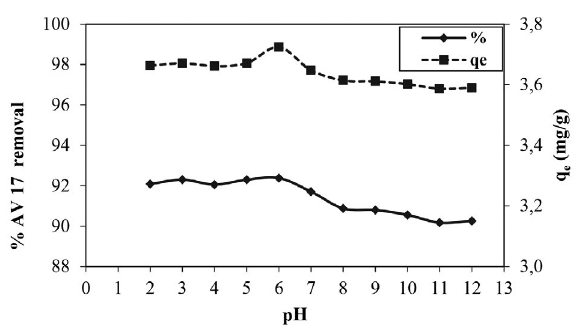
Fig. 8. Impact of pH on the removal of AV 17 onto AAPS.